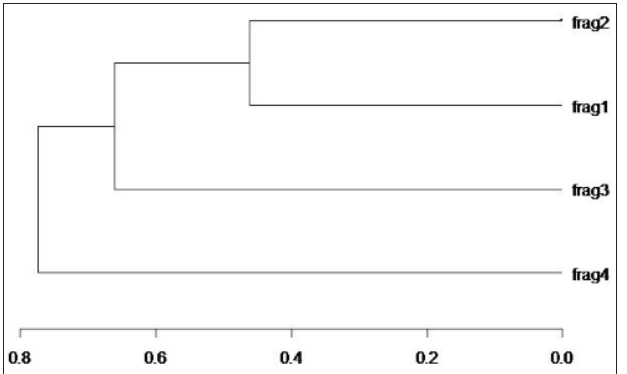
Fig 2 . Index of similarity in the social wasps’ fauna in the four forest fragments in the municipalities of Inconfidentes and Ouro Fino, in the south of the state of Minas Gerais in the Southeast region of